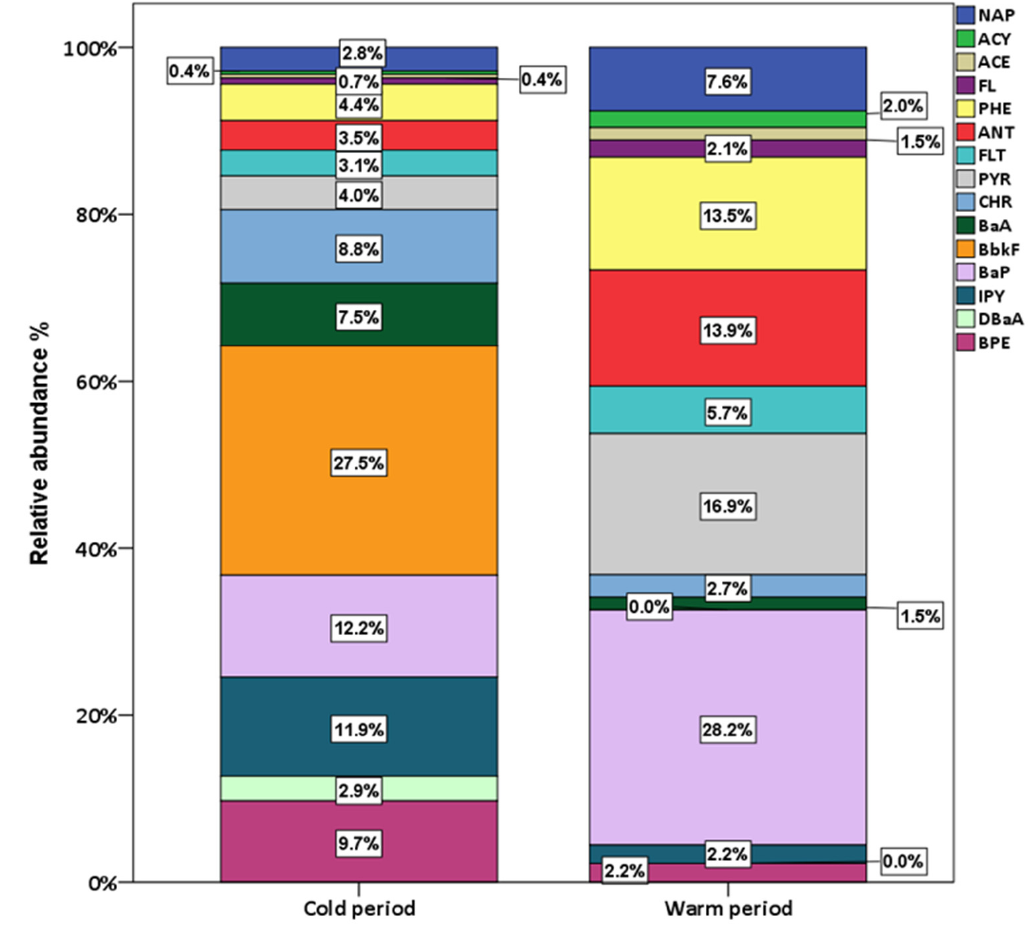
Figure 3. Relative abundance among PAH compounds for the cold and warm periods.